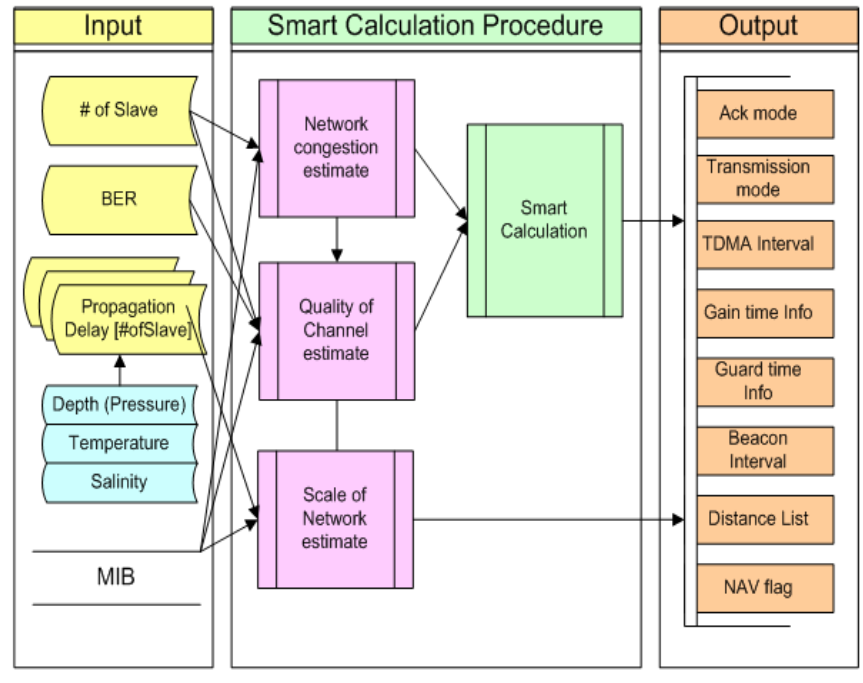
Figure 4. Smart Calculation